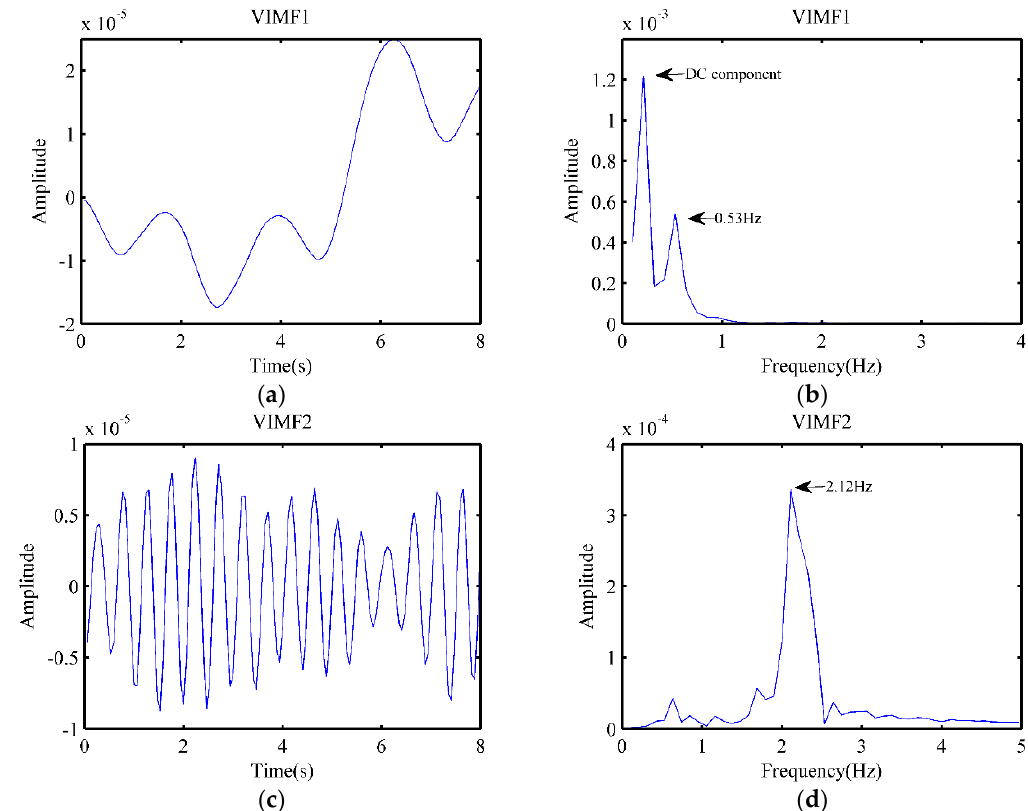
Figure 12. Results after VMD. ( a ) The waveform of VIMF1; ( b ) The spectrum of VIMF1; ( c ) The waveform of VIMF2; ( d ) The spectrum of VIMF2.